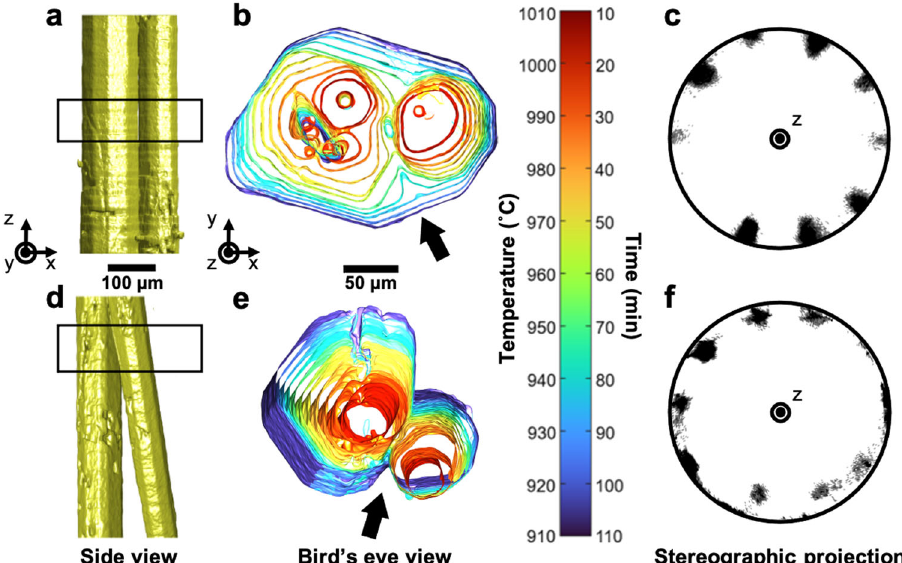
Fig. 1 Tracking grain impingements in real-time. a Side view ( ^ z (cid:1) ^ x in the specimen frame) of two d-QCs with parallel 〈 00001 〉 long axes, observed after 50 min of cooling (1 °C/min) from 1020 °C. b Birds-eye view ( ^ x (cid:1) ^ y ) of quasiperiodic plane corresponding to boxed region shown in a . c Stereographic projection of interface (facet) normal vectors of the outermost isochrone (910 °C) in b . Zone axis is ^ z . Facets are evenly projected (~ 36° apart) as peaks along the circumference (or primitive circle) of the projection plane, which implies the formation of a single, decaprismatic QC along ^ z . The missing tenth peak can be attributed to the less developed facet in b . d Side view of d-QCs with non-parallel 〈 00001 〉 long axes, observed at the same timestep as in a . e Birds-eye view of the boxed region shown in d . f Stereographic projection of interface normal vectors of the outermost isochrone (910 °C) in e . Zone axis is again ^ z . Quasiperiodic facets of two QCs are inclined to the projection plane, and thus the corresponding peaks do not lie on the primitive circle. Peaks are not always separated by 36° either, suggesting a superposition of two single crystal patterns and hence a bi-quasicrystalline structure. Isochrones of the solid – liquid interface in b and e are colored to illustrate the passage of time, with early times in red and late times in blue. Times and temperatures in b and d are as follows: 10 min (1010 °C), 20 min (1000 °C), 30 min (990 °C), 40 min (980 °C), 50 min (970 ∘ C), 60 min (960 °C), 70 min (950 °C), 80 min (940 °C), 90 min (930 °C), 100 min (920 °C) and 110 min (910 °C). Thick black arrows in b and e point to the evolution of the grain-boundary groove in time.